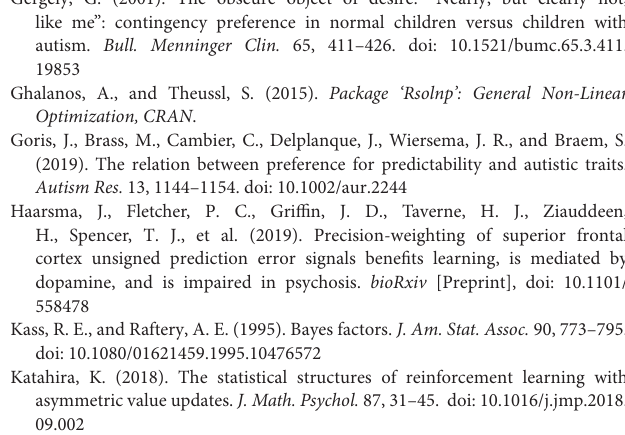
FIGURE S1 | Probability of choosing a sure option for each subject. We found that behavioral performance on our proposed model is more similar to the real data than other models for some subjects, especially those whose probability of choosing a sure option is high. QL, Q-learning model; utility, utility model; RSQL, risk-sensitive Q-learning model; surprise, surprise-sensitive utility model. FIGURE S2 | Plot and second-order polynomial fit for the probability of choosing a sure option depending on the surprise decay rate ( − 1 ≤ d ≤ 1 ) and learning rate. When a surprise decay rate ( d ) is positive, risk aversion increases as the surprise decay rate ( d ) increases. However, when a surprise decay rate ( d ) is negative, risk aversion decreases as d decreases. FIGURE S3 | Estimated parameters of the surprise-sensitive utility model in the Niv et al. (2012) dataset. FIGURE S4 | The results of the analysis on the dataset of Goris et al. (2019). (A) Model evidence for each model: data are presented as the mean (bars) and data value (plots and lines) per subject, (B) Bayesian model selection, (C) estimated parameters of the surprise-sensitive utility model. We found that the surprise-sensitive utility model had the largest value and had a decisively higher protected exceedance probability. QL, Q-learning model; utility, utility model; RSQL, risk-sensitive Q-learning model; surprise, surprise-sensitive utility model. FIGURE S5 | Numbers for choosing each option of the Q-learning model and surprise-sensitive utility model. Data are presented as the mean ± standard error. (A) We compared two safe options ( p = 0.9) with a small value difference ( r = 1 or 0.8) and found that agents chose higher valued options less in the proposed model than in the Q-learning model. (B) We compared two safe options ( p = 0.9) with higher values ( r = 1) and lower values ( r = 0.3) and found that agents chose the higher-value option in the proposed model more than the Q-learning model. QL, Q-learning model; surprise, surprise-sensitive utility